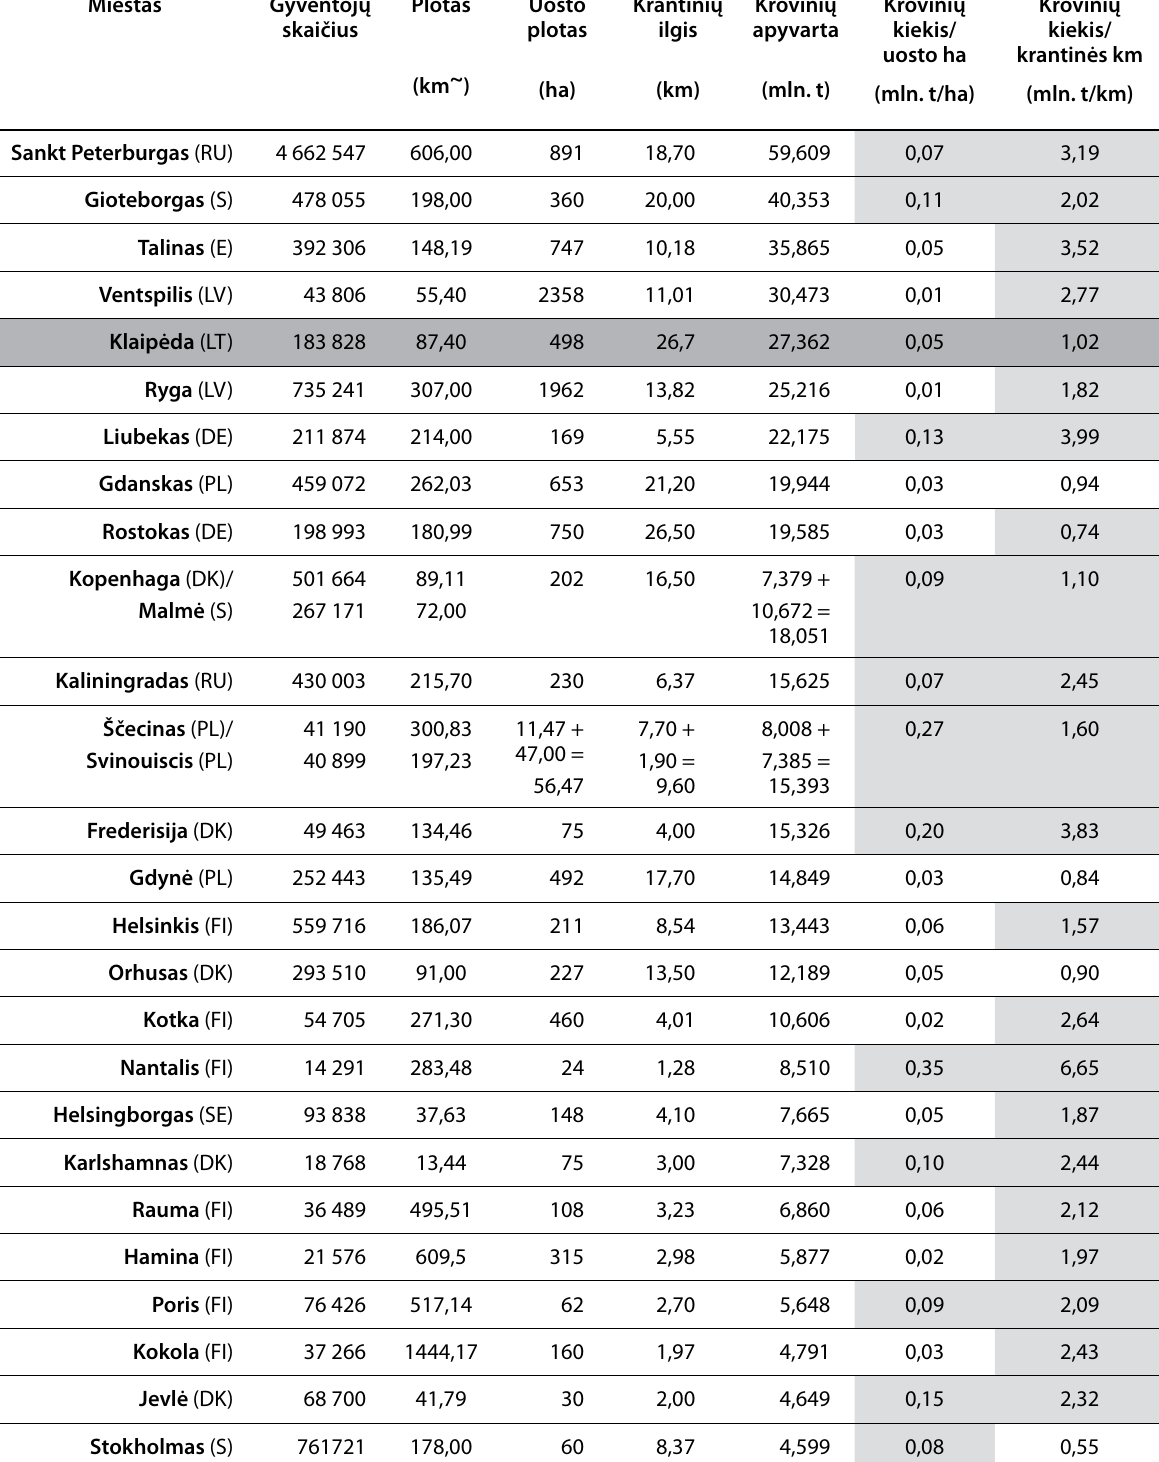
Table 1. efficiency of waterfronts used by the baltic seaports in